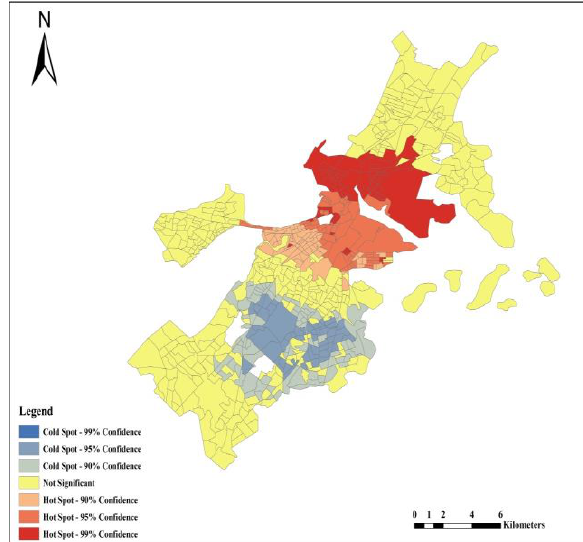
Figure 2. Spatial Clusters of Tweets in Boston